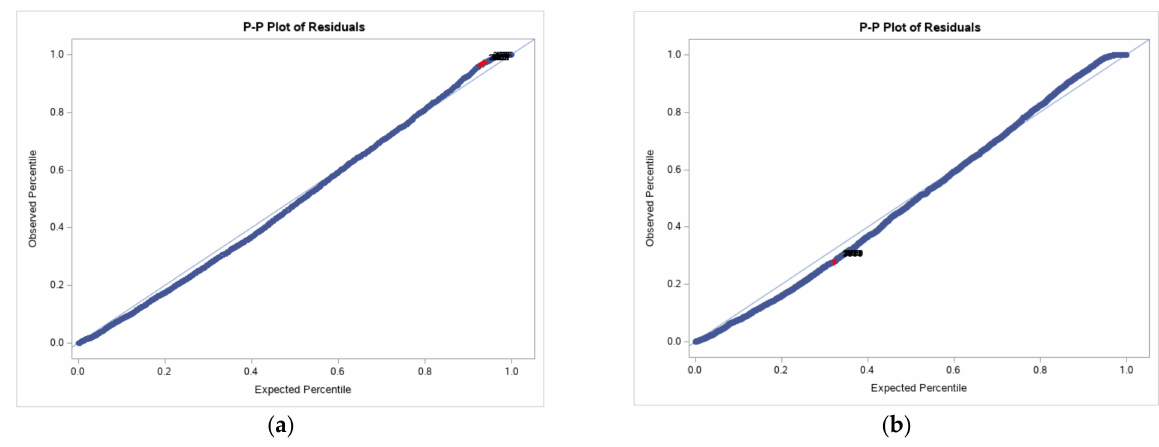
Figure 6. P-P plot of residuals ( a ) pre-trial data set, ( b ) post-trial data set.